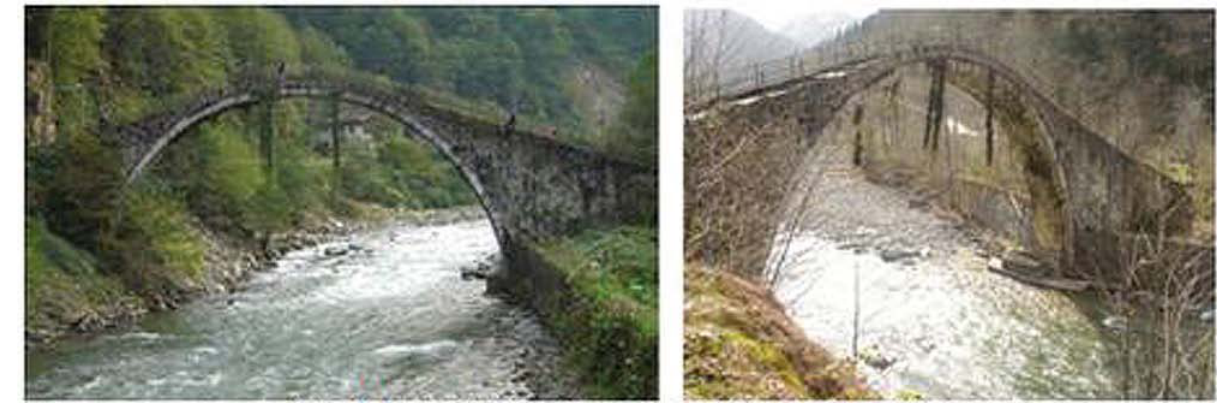
Fig. 2. Some views of Şenyuva historical arch bridge